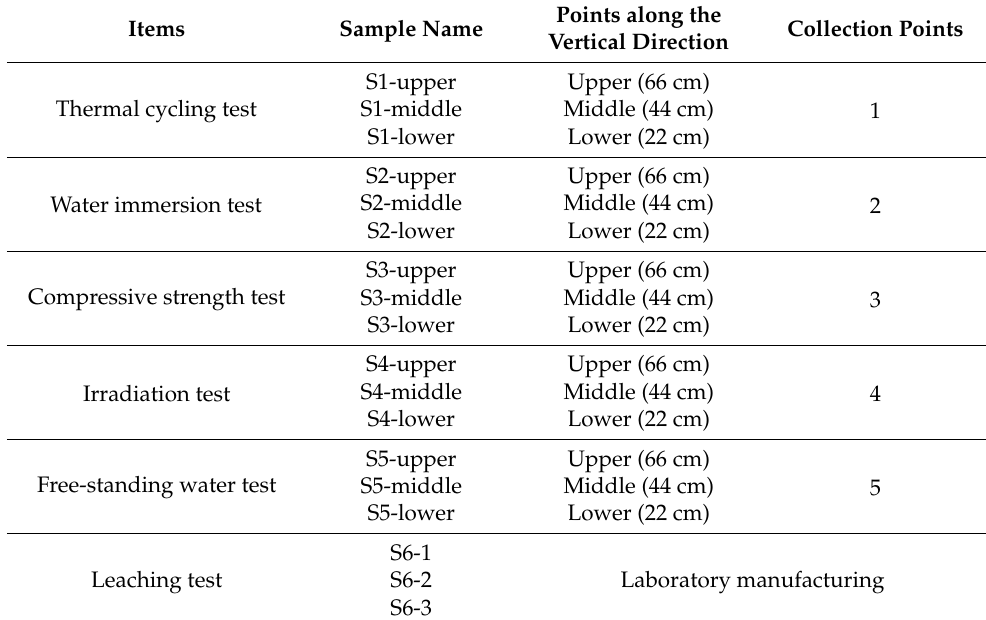
Table 8. Sample codes, sample collection points, and vertical-direction positions, along with test items.